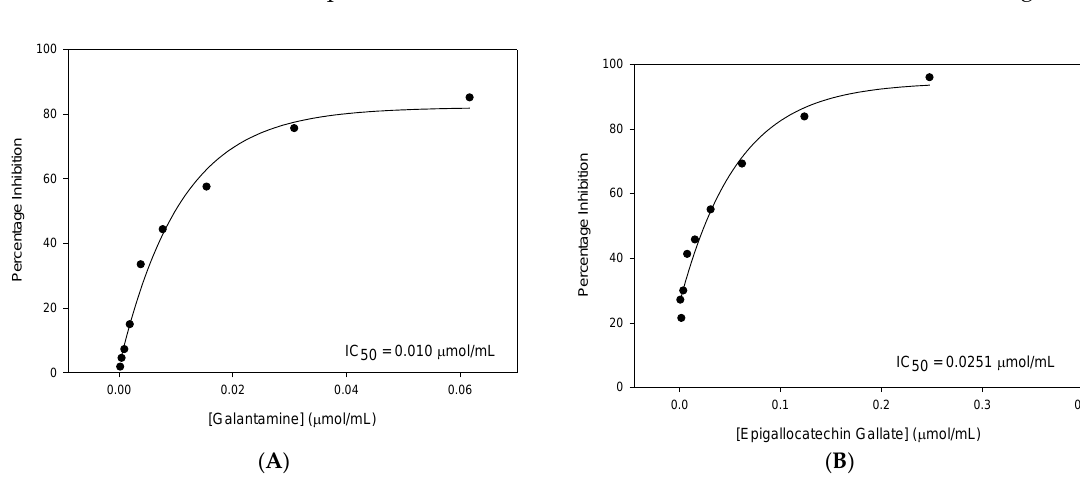
Figure 3. IC 50 plots for BuChE inhibition: concentration against percentage inhibition for each of the active compounds tested. ( A ) Gal and ( B ) EGCG.